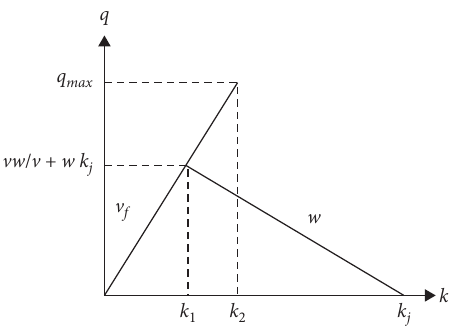
Figure 9: The fundamental diagram with